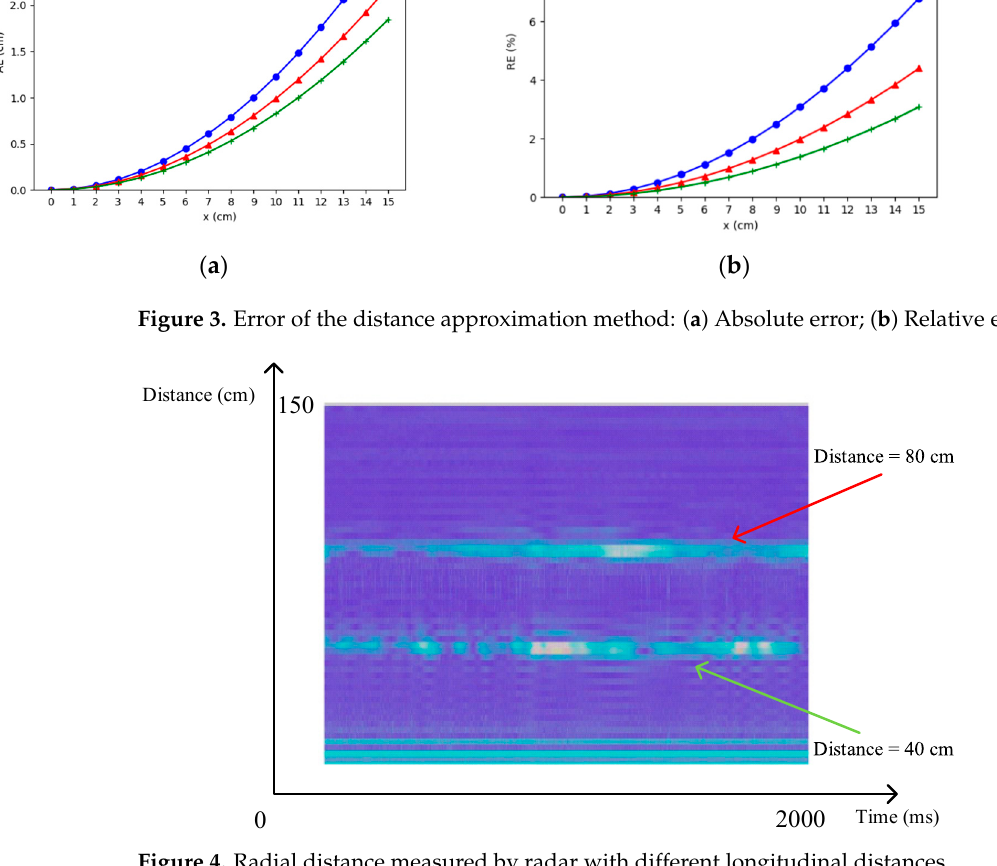
Figure 4. Radial distance measured by radar with different longitudinal distances.